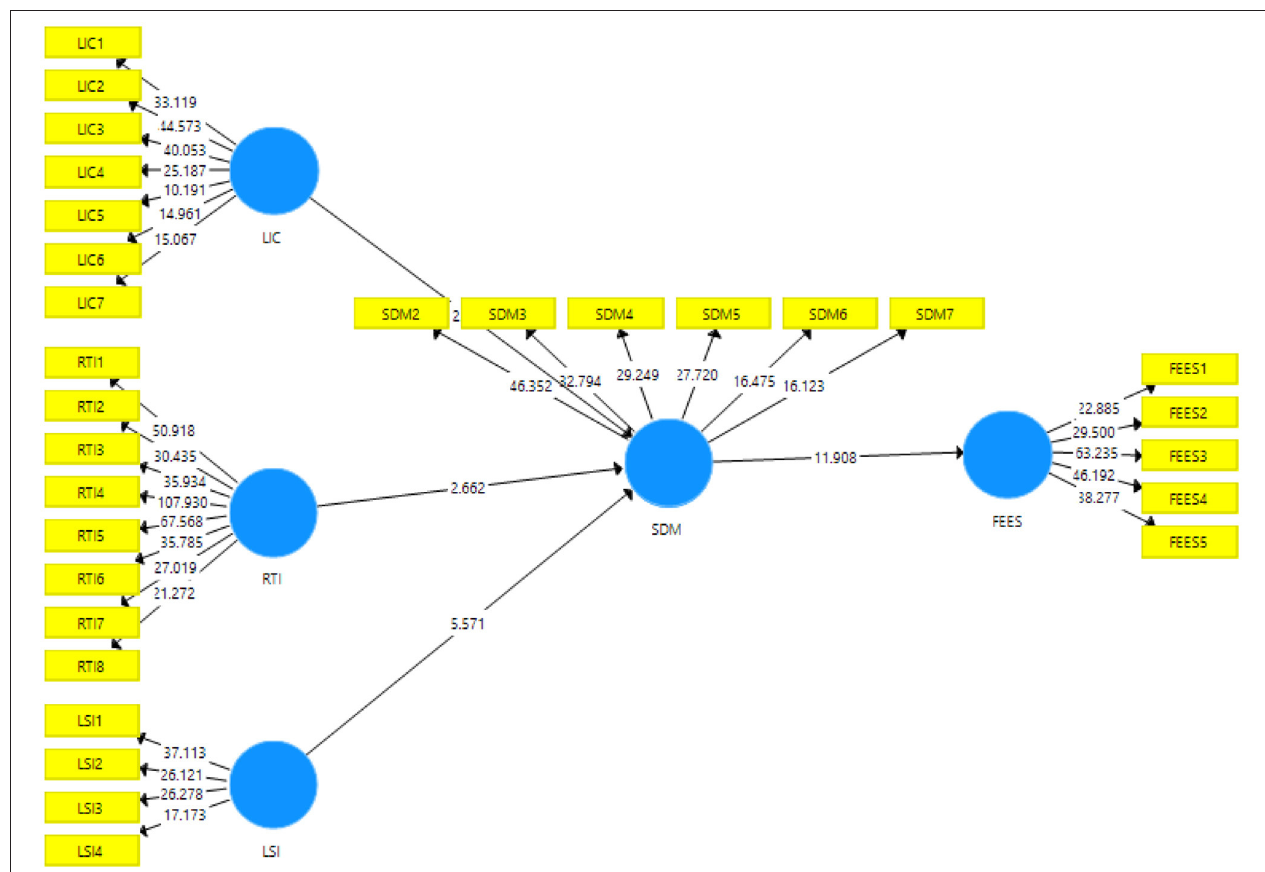
FIGURE 4 | Structural model